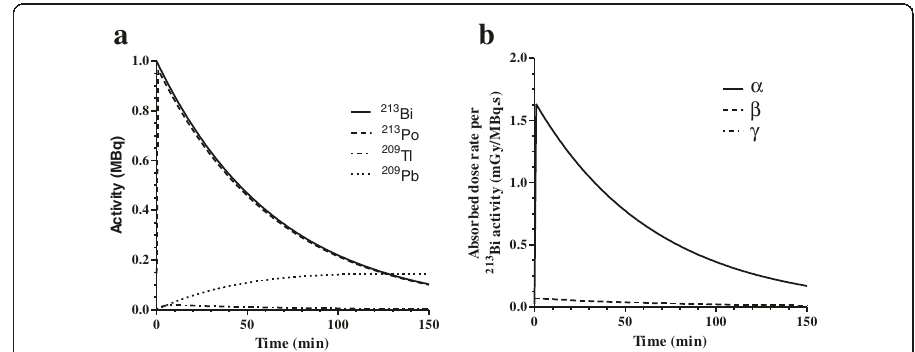
Fig. 5 Time-integrated activity of 213 Bi, 213 Po, 209 Tl and 209 Pb determined by Bateman equations a and the resultant total absorbed dose rate b as a function of time, see Table 2. The majority of the absorbed dose rate (96 % at 60 min) is caused by the α -particles from 213 Bi and 213